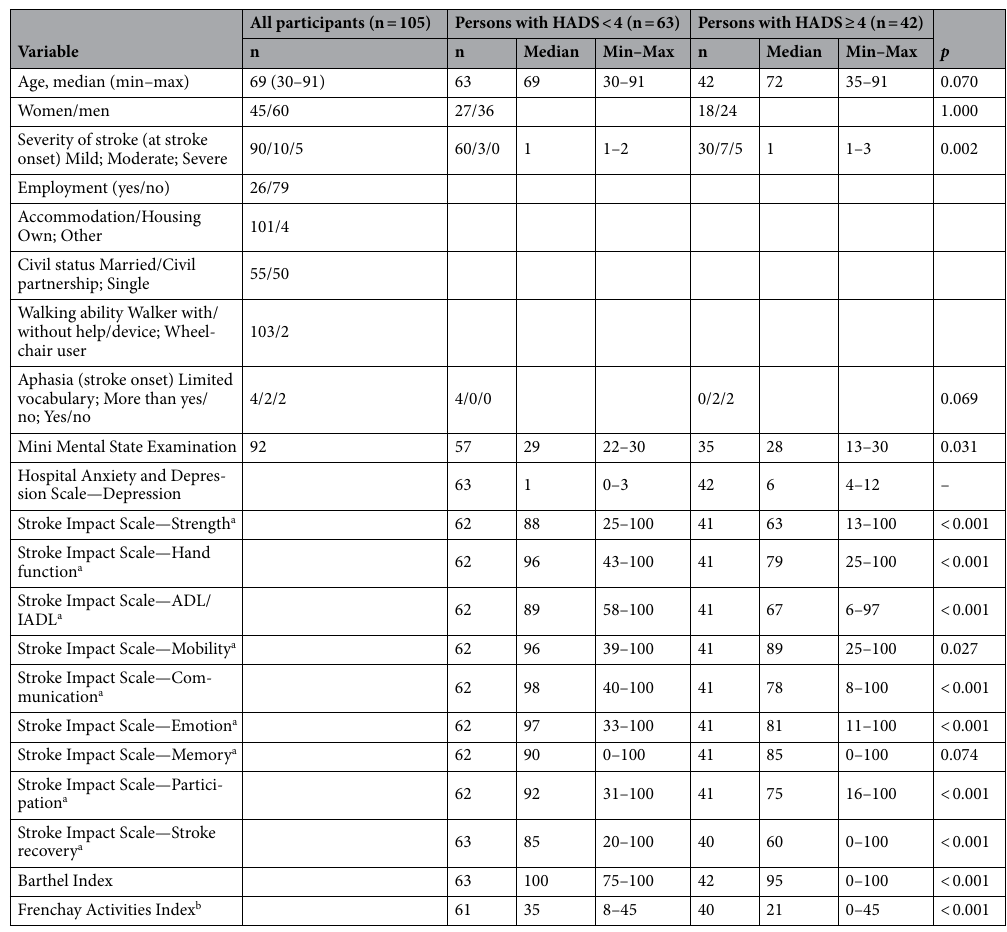
Table 1. Characteristics of participants 6 years after stroke, and comparisons between participants with and without depression symptoms. a n = 103; b n = 101.